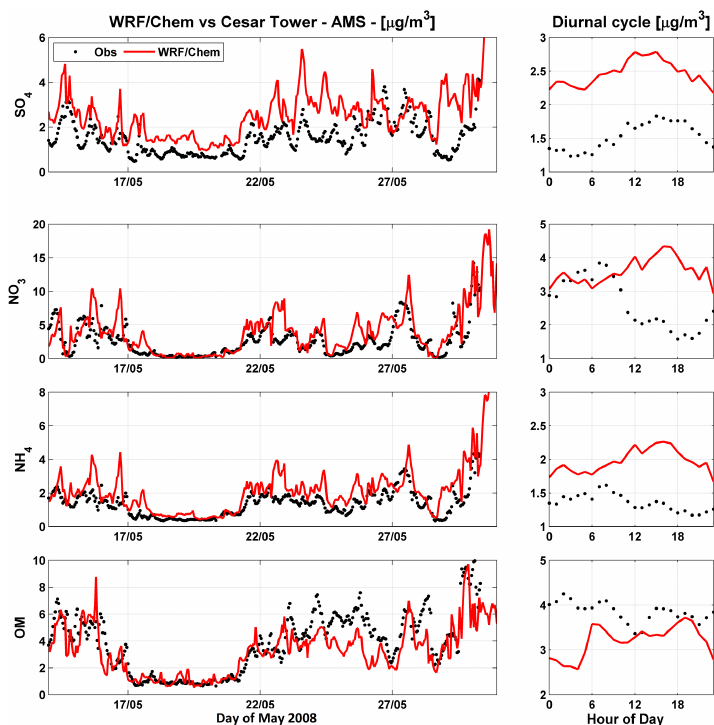
Figure 5. As in Fig. 4, but for aerosol mass speciation at Cesar observatory observed at 60m